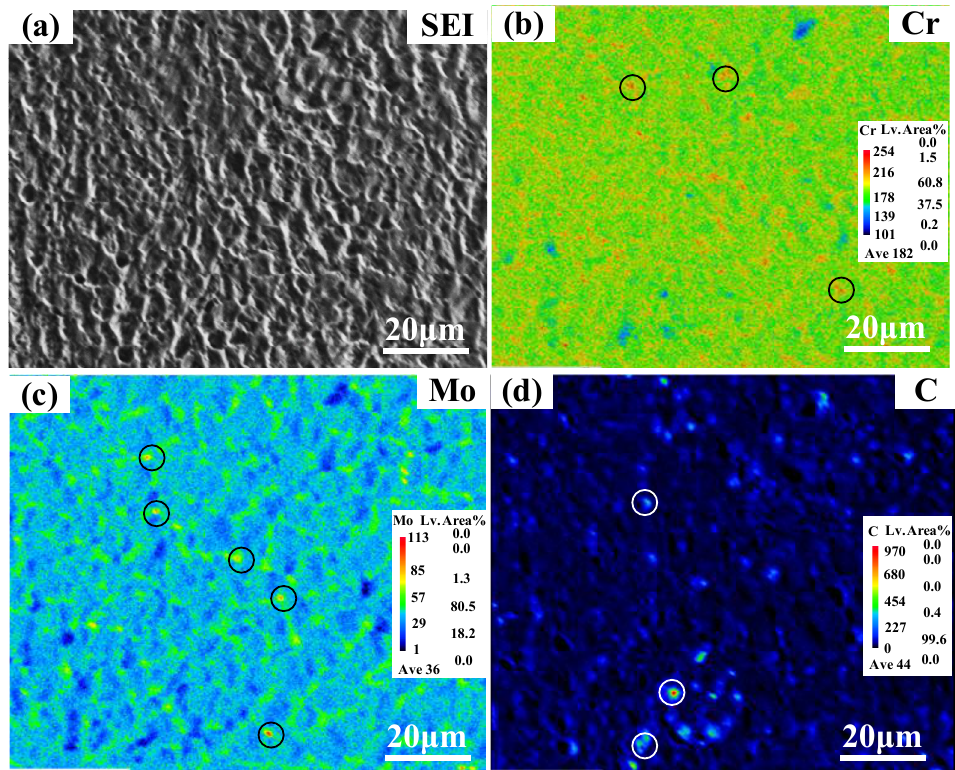
Figure 7. SEM image and microzone composition analysis of cladding layer (EPMA). ( a ) SEI Fig.; ( b ) Distribution of Cr; ( c ) Distribution of Mo; ( d ) Distribution of C.